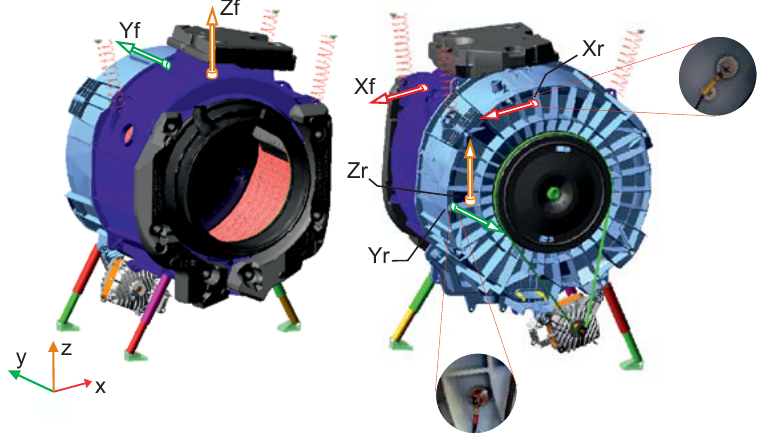
Figure 1. Measurement points on the oscillating group.